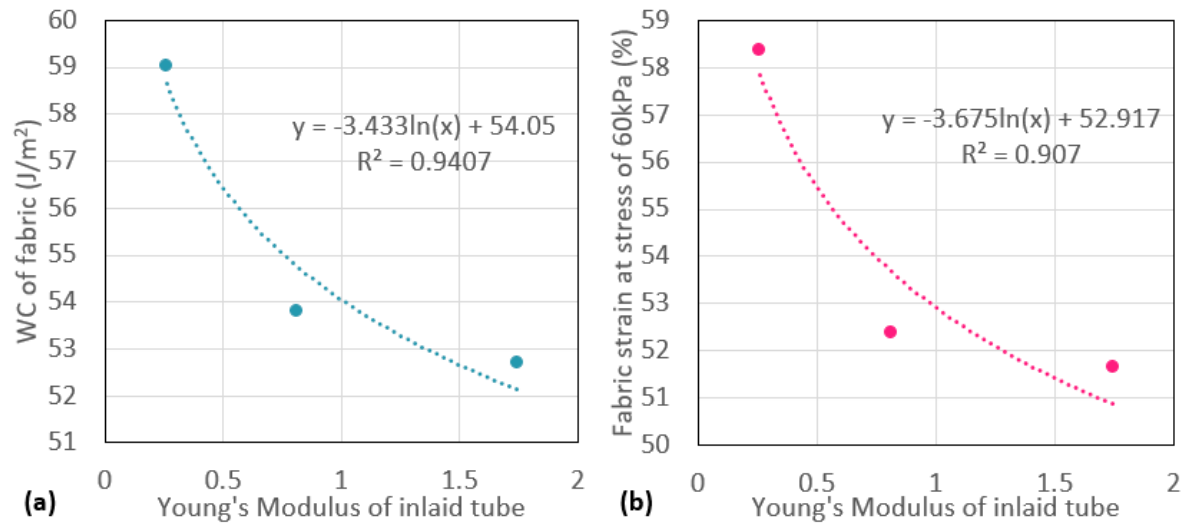
Figure 5. Relationship between the Young’s modulus of the inlaid tube, ( a ) the compression energy of the fabric samples, and ( b ) the fabric strain at a stress of 60 kPa.